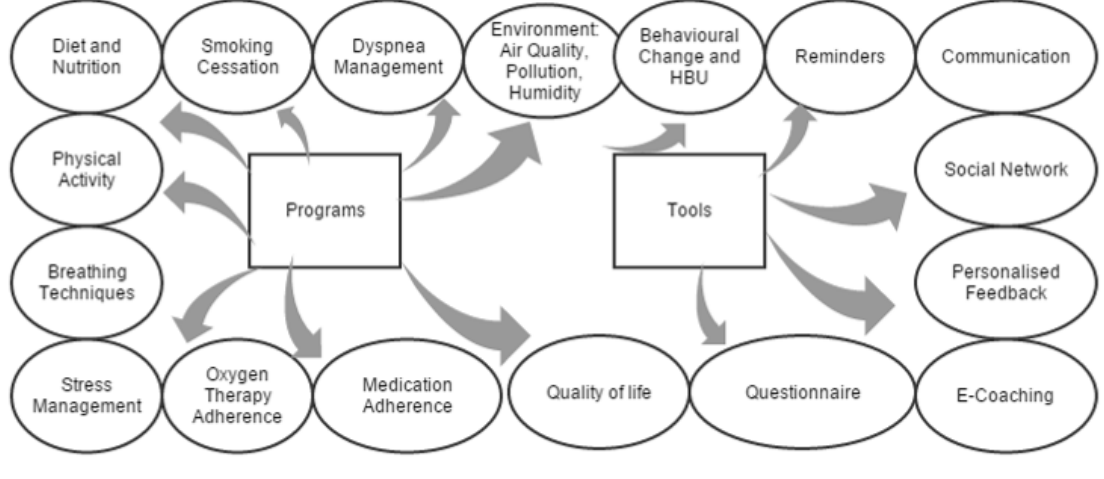
Figure 3. Features, including tools and programs, identified in this study that should be taken into consideration when building a support tool for patients with chronic obstructive pulmonary disease.